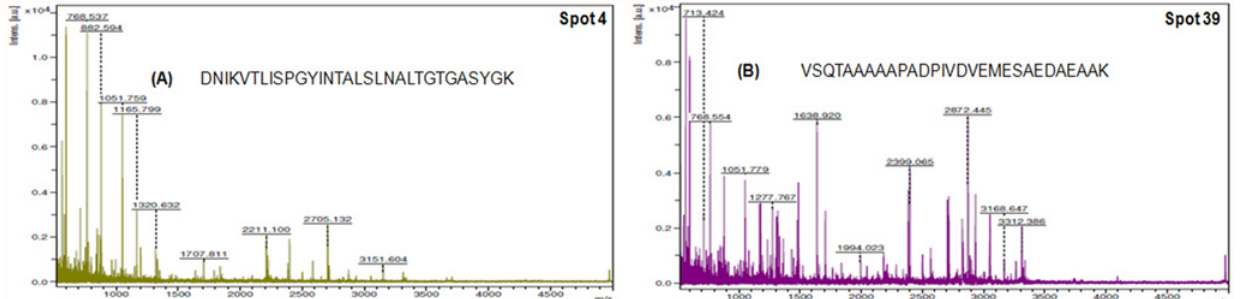
Fig 4. Peak spectrum analyzed by MALDI-TOF in An . stephensi multi-resistant species. (A) Representative PMF spectrum of over expressed protein i.e Short-chain dehydrogenase reductase (DNIKVTLISPGYINTALSLNALTGTGASYGK) (spot no. 4) (B) Representative PMF spectrum of down regulated protein i.e 26S proteasome non-ATPase regulatory subunit (VSQTAAAAAPADPIVDVEMESAEDAEAAK) (spot no.39).